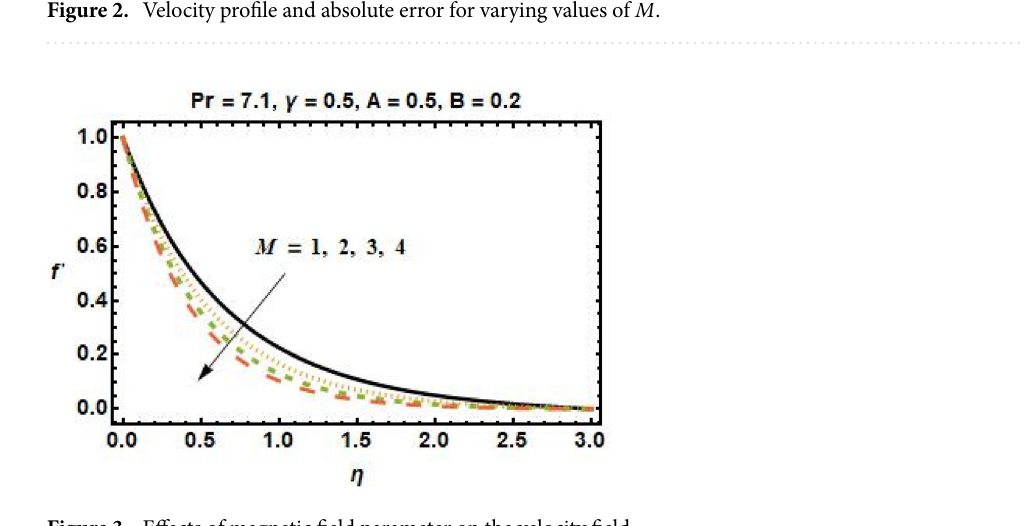
Figure 3. Effects of magnetic field parameter on the velocity